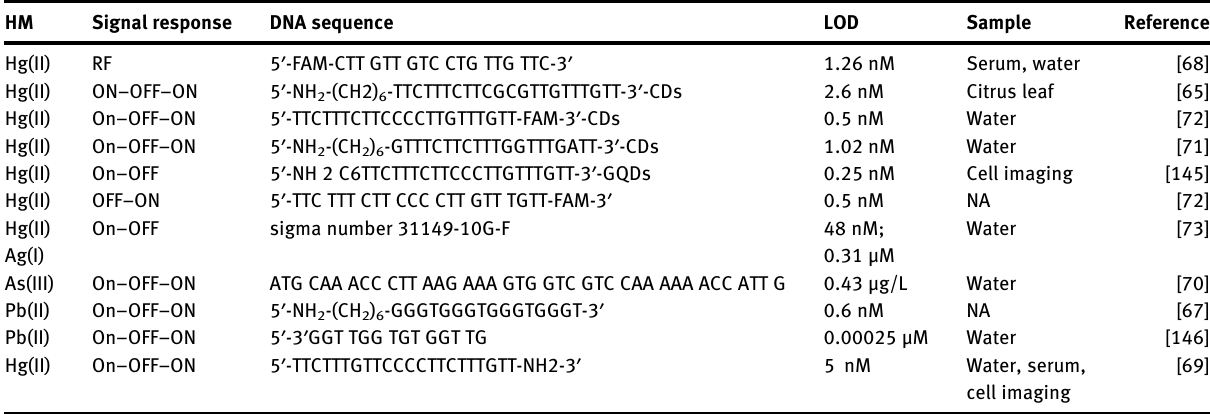
Table  : Aptamer-based CDs fl uorescence sensors for HMs detection. HM Signal